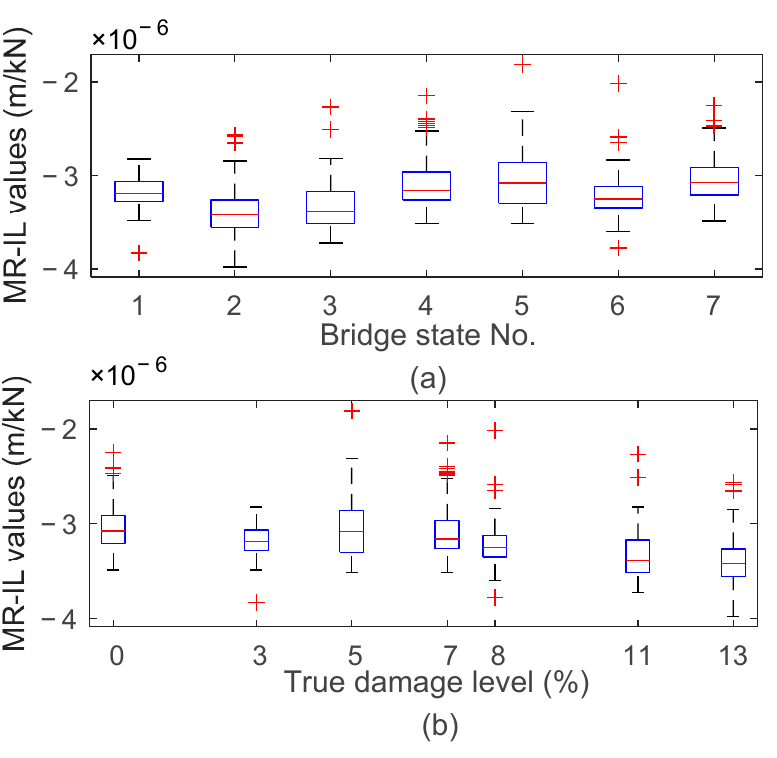
Figure 13. Box plot of mid-span fundamental MR-IL values of half-car model for Profile 1, organised by ( a ) bridge state number and ( b ) damage level.